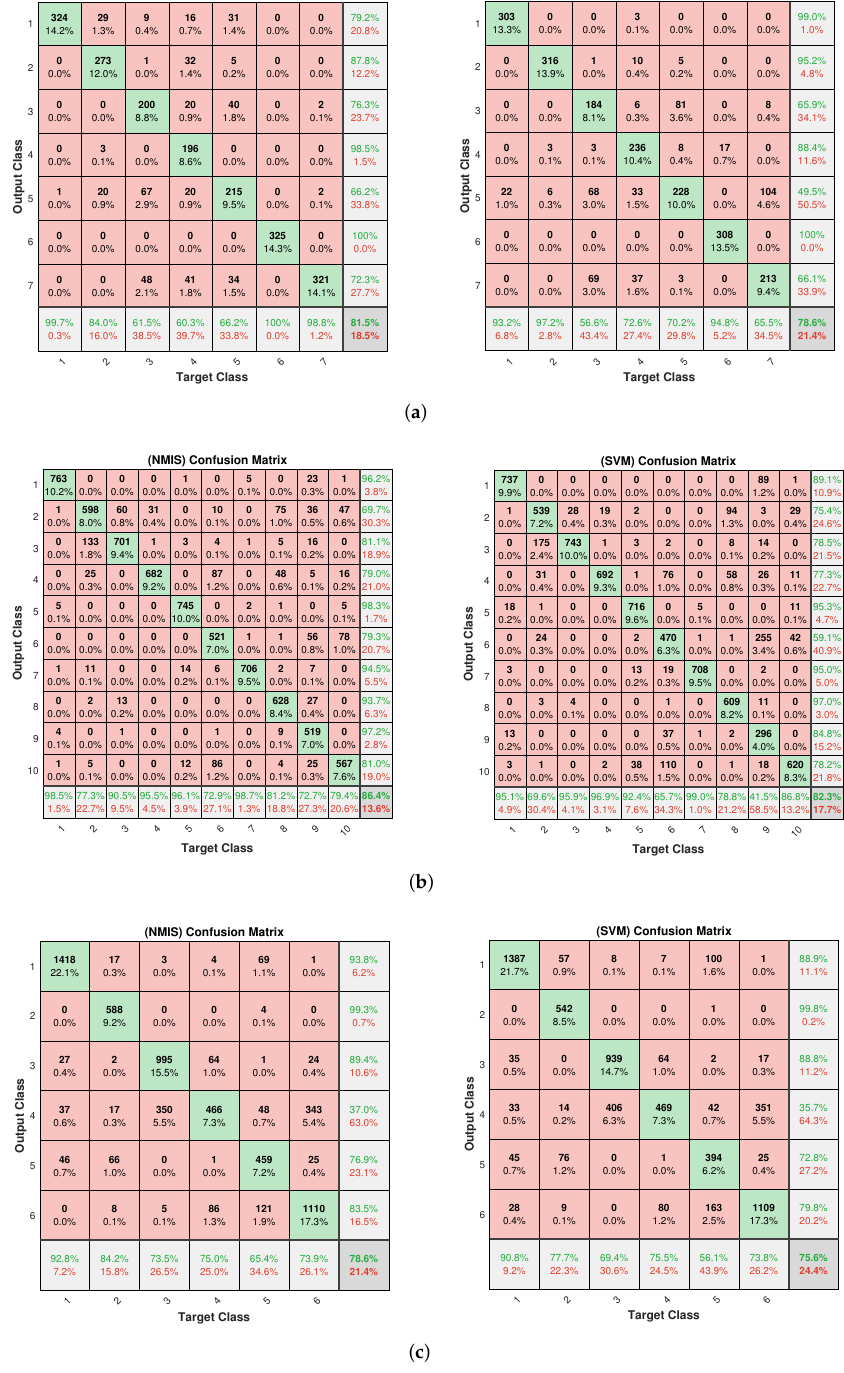
Figure 8. The confusion matrix of NMIS and SVM on ( a ) SEGMENTATION, ( b ) PENDIGITS and ( c ) SATELLITE datasets. Each orange square represents the number of wrongly predicted instances. The main diagonal represents the number of correctly predicted instances. The bottom and right light gray rectangles indicate the prediction accuracy of the corresponding instance